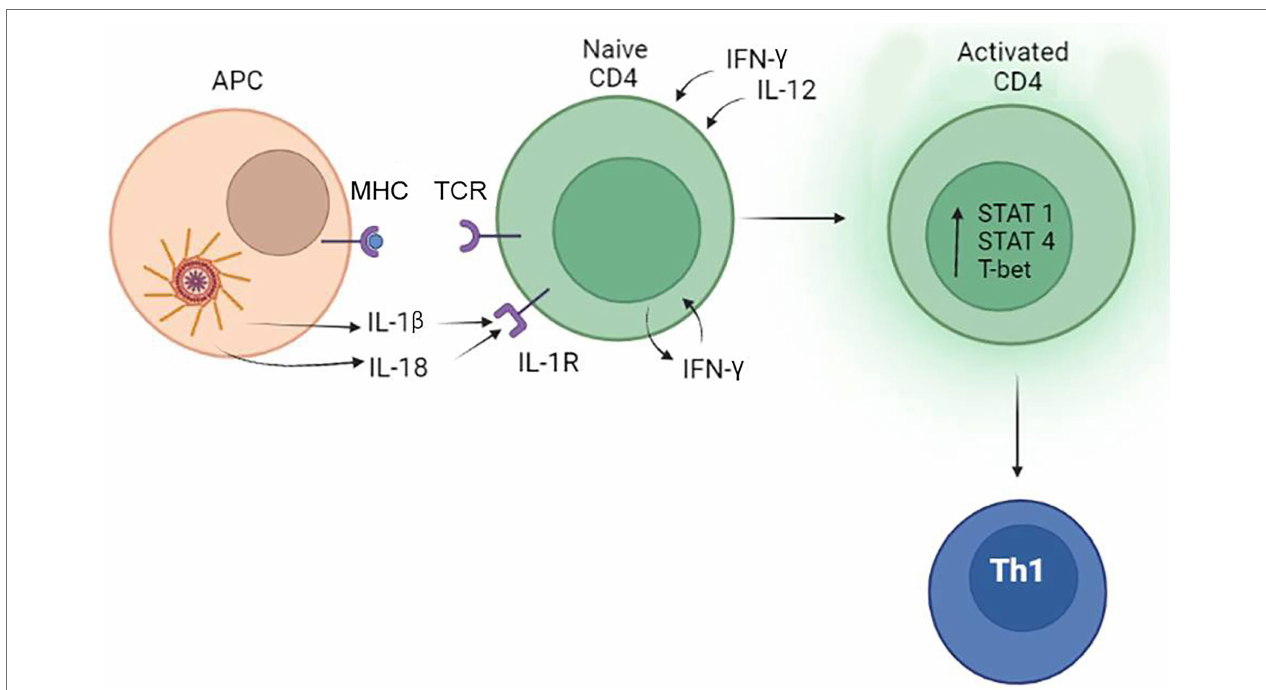
FIGURE 3 | The role of the inflammasome in the differentiation of Th1 lymphocytes. Inflammasome products IL-1 β and IL-18 can bind to IL-1R and support the commitment of Th1 lymphocytes by inducing the release of IFN- γ . IFN- γ and IL-12 produced by tissue cells also promotes activation and differentiation of CD4 + lymphocytes to Th1